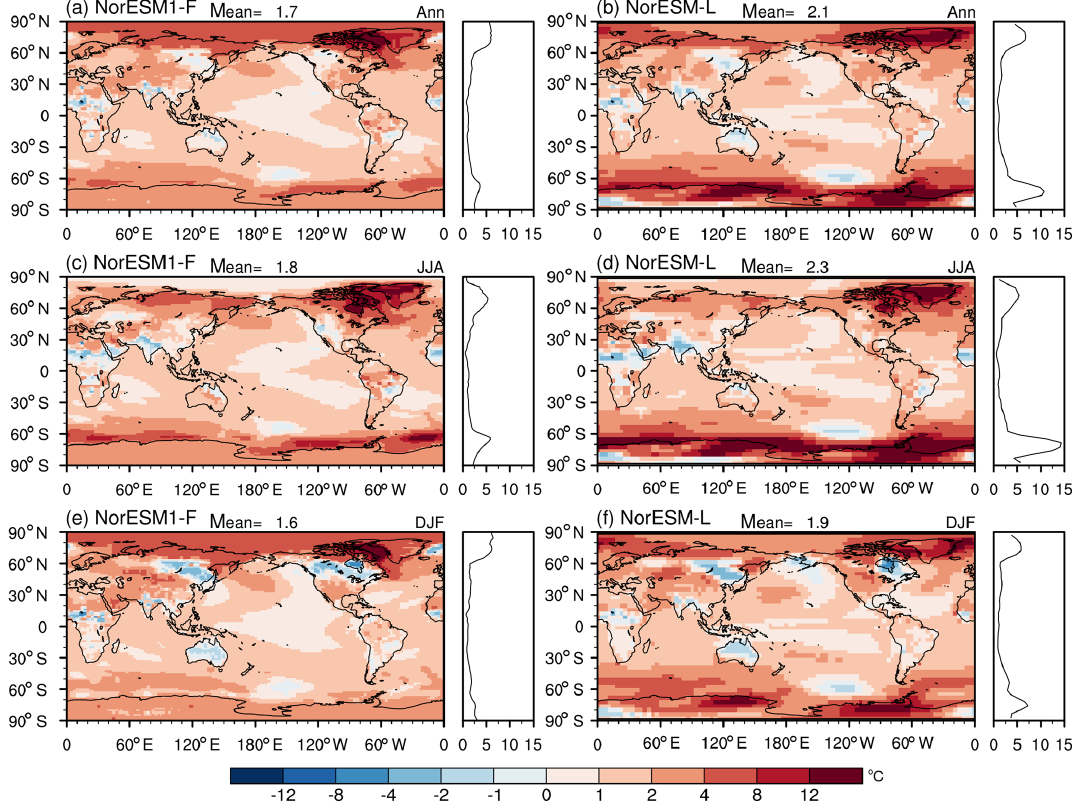
Figure 1. The difference in climatological surface air temperatures (units: ◦ C) between Pliocene and preindustrial experiments according to NorESM1-F (a, c, e) and NorESM-L (b, d, f) for the annual mean (a, b) , boreal summer (c, d) , and boreal winter (e, f) . The zonal mean is shown to the right of each